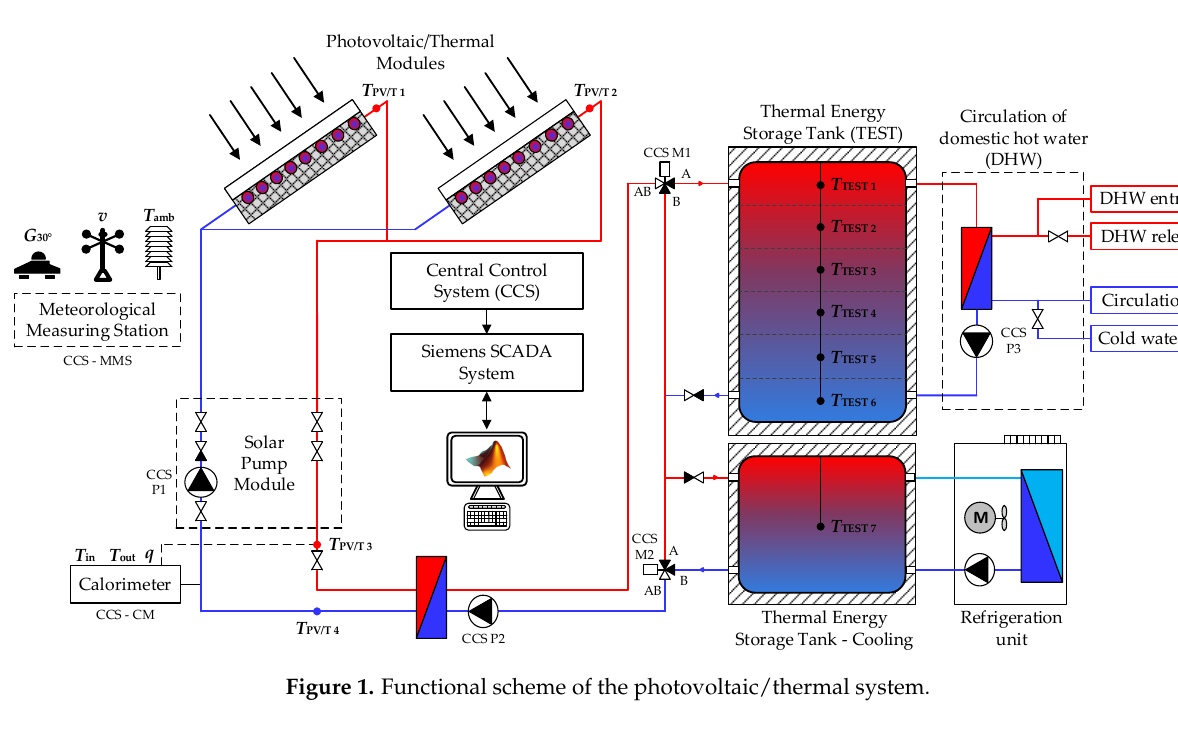
Figure 1. Functional scheme of the photovoltaic/thermal system.